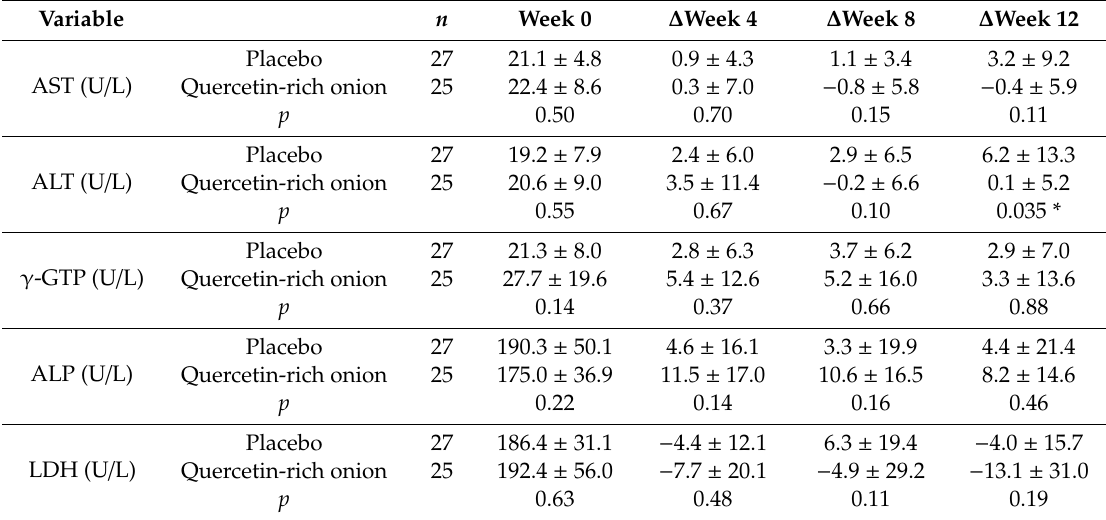
Table 6. Liver marker results for the placebo and quercetin-rich onion